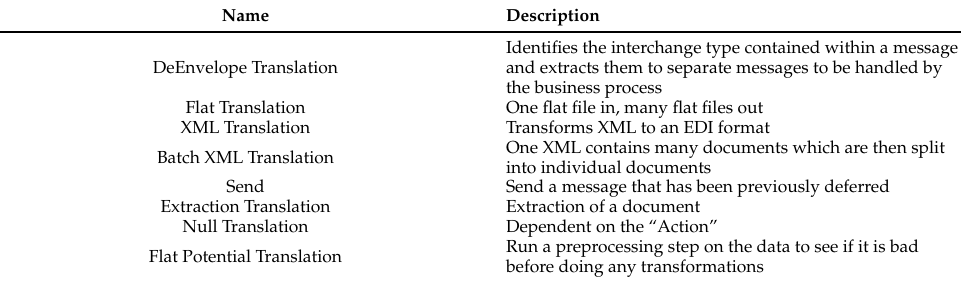
Table 23. Message category data dictionary.